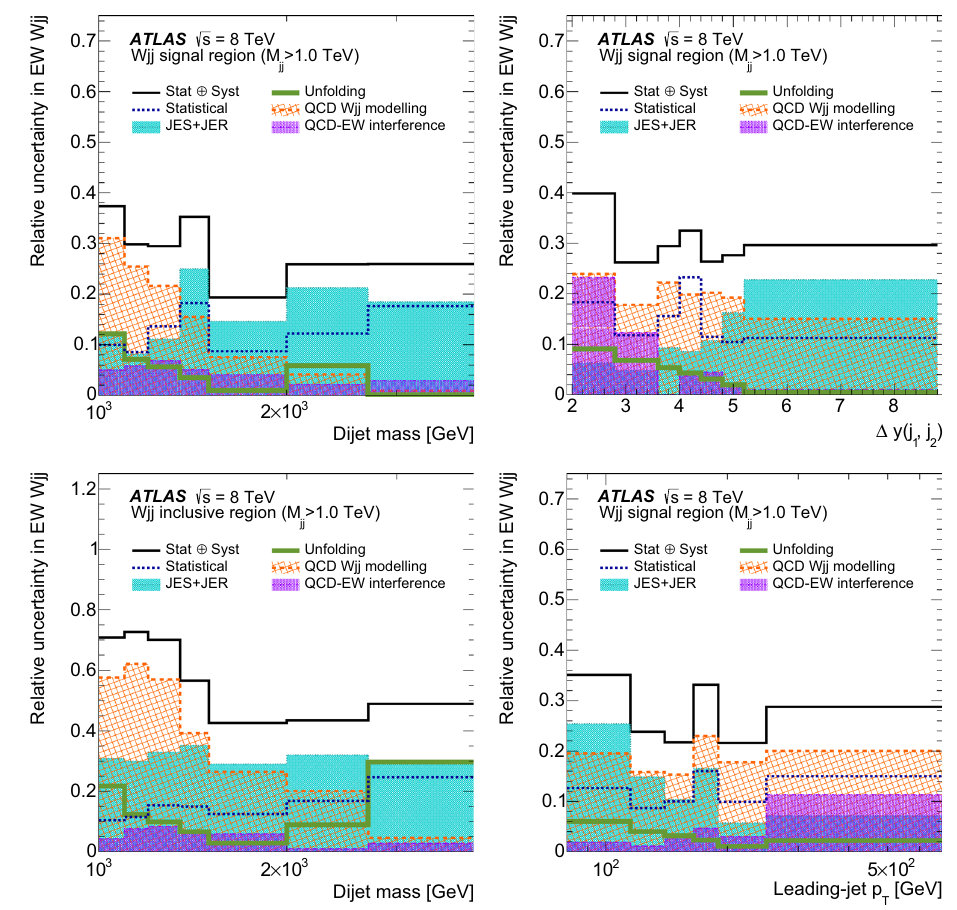
M jj > 1 TeV inclusive region ( bottom left ); and leading-jet p T in the high-mass signal region ( bottom right ). Dominant contributions to the total systematic uncertainty are highlighted separately